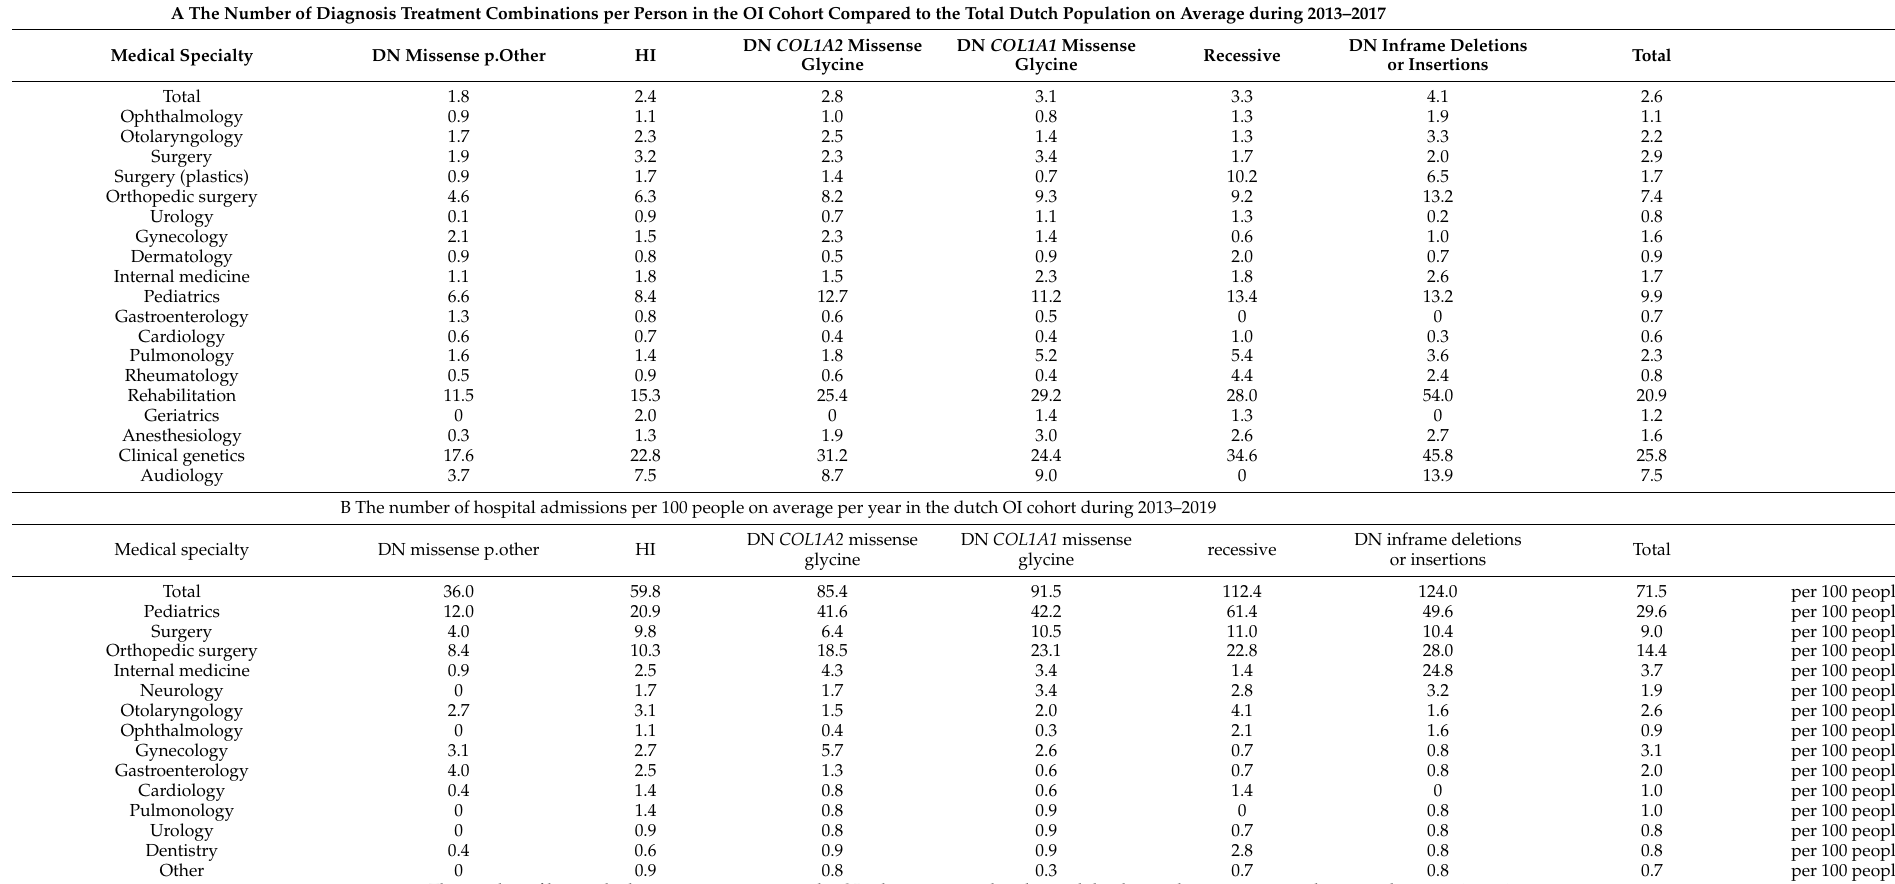
Table 2. The number of diagnosis-treatment combinations and hospital admissions in the Dutch OI cohort compared to the total Dutch